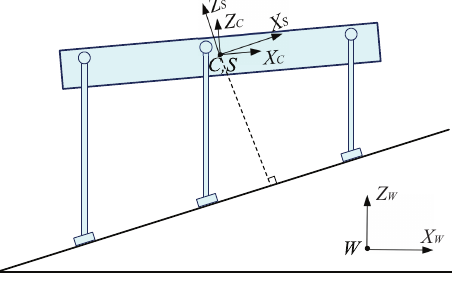
Figure 7. The diagram of the coordinates